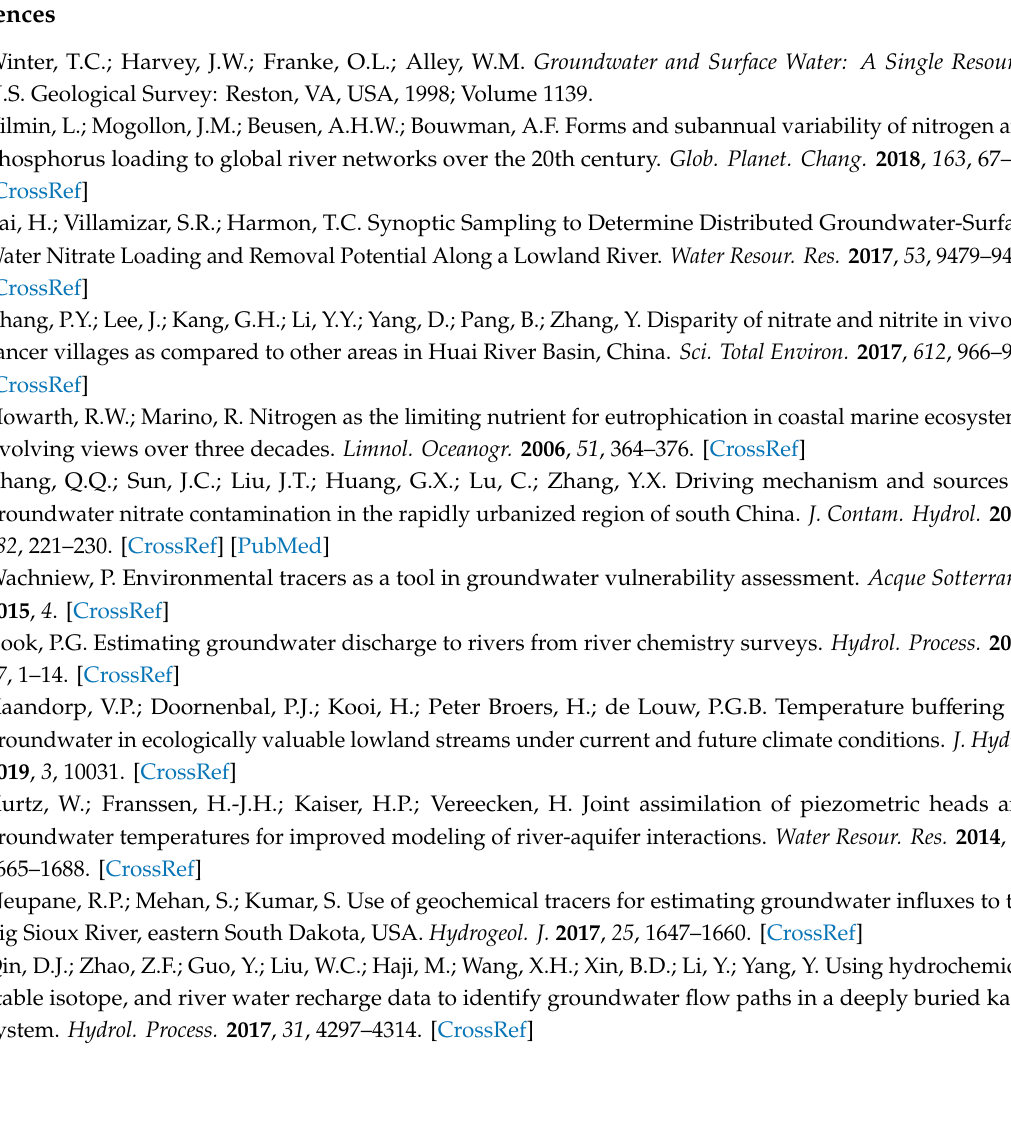
Table S1: Electric conductivity (EC), δ 2 H, δ 18 O, and 222 Rn data of the surface water and riparian groundwater samples for this study. Table S2: Hydro-chemical parameters. NO 2 -N, NH 3 -N, NO 2 -N, TN, DOC, and CODcr data of the surface water and riparian groundwater samples for this